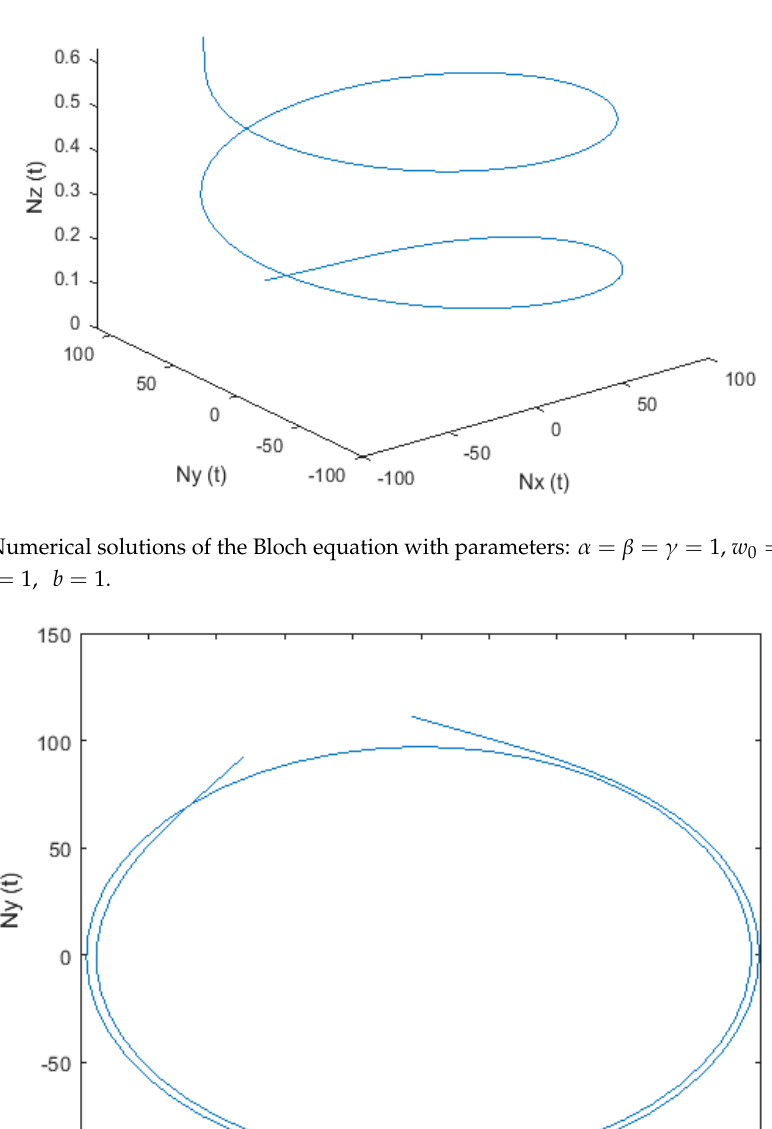
Figure 2. Numerical solutions of the Bloch equation in plane (𝑁 (cid:3051) vs.𝑁 (cid:3052) ) with parameters: 𝛼 = 𝛽 = 𝛾 = 1 , 𝑤 (cid:2868) = 12 , 𝑇 (cid:2869) = 1 , 𝑇 (cid:2870) = 20, 𝑎 = 1, 𝑏 = 1 .